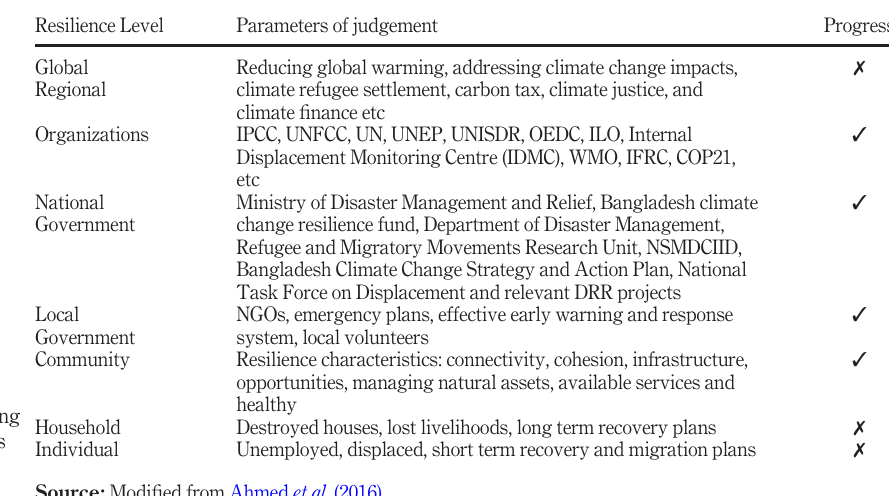
Table II. Progress of